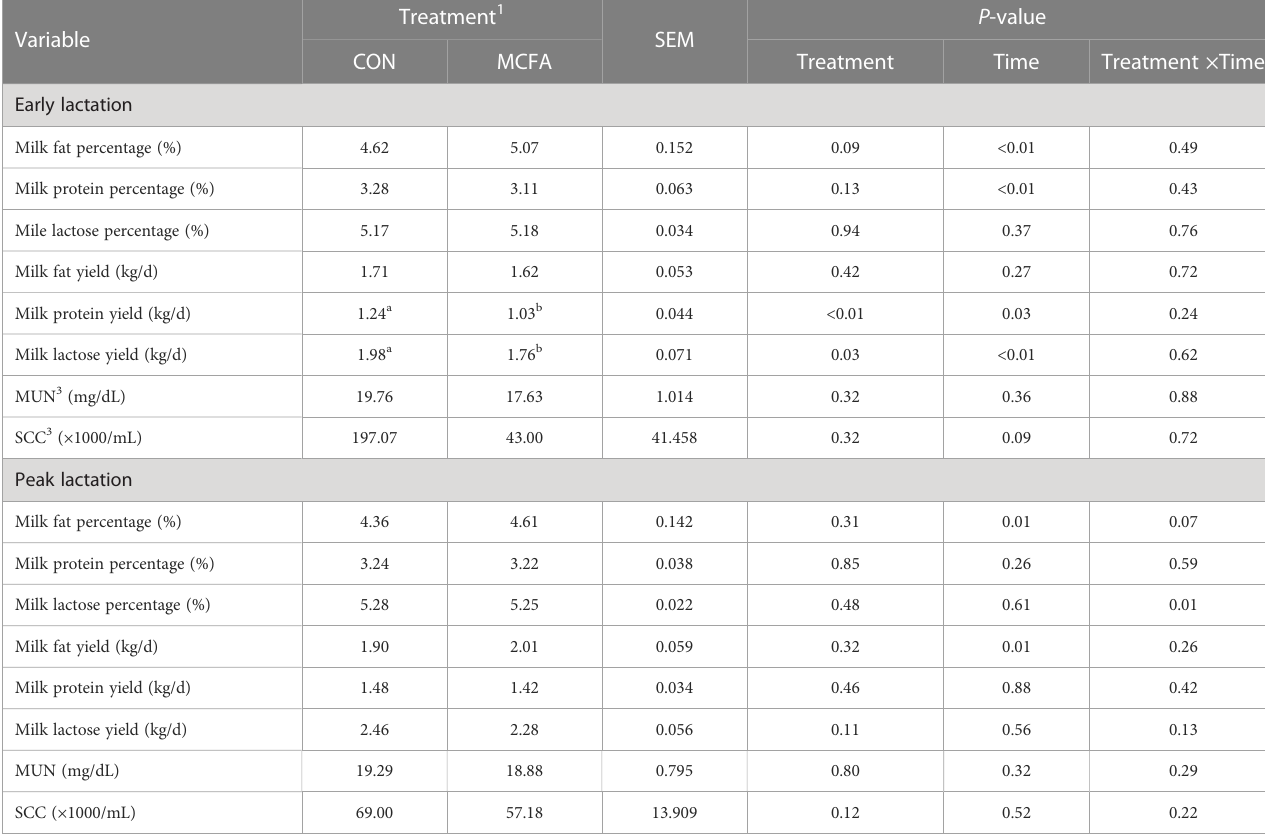
TABLE 3 Effects of feeding medium-chain fatty acid on milk composition of early lactation and peak lactation cows 2 .